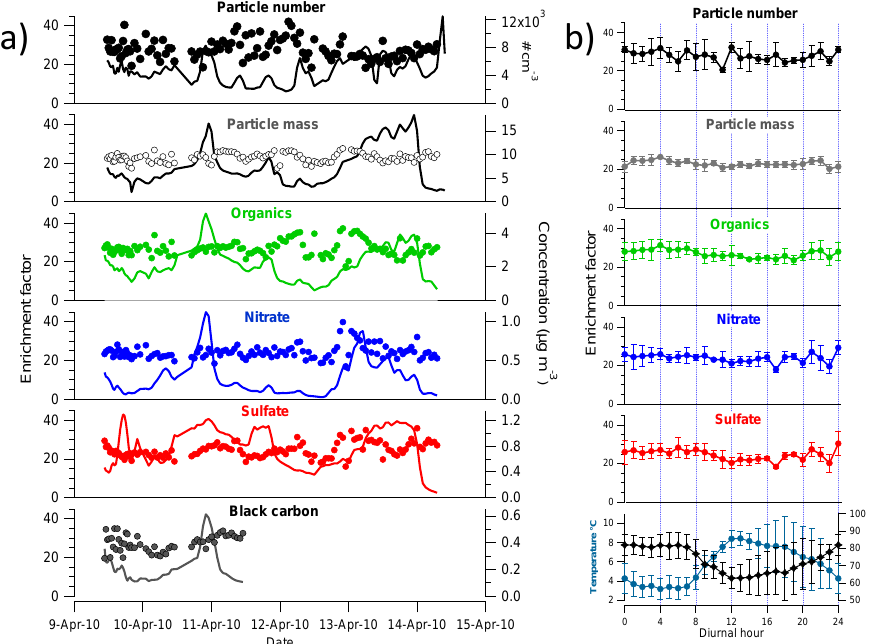
Figure 5. Time series for EFs (dots) and ambient concentrations (lines) (a) and diurnal trends for EFs, ambient temperature and relative humidity (b) . Particle number and mass were measured with the SMPS and organics, nitrate and sulfate and r-BC with the SP-AMS. Particle mass was calculated by using the density of 1.48gcm − 3 . Diurnal trend for EF of r-BC is not shown as it was calculated only when the laser was on (2 days). Ammonium is shown separately in Fig. 8.